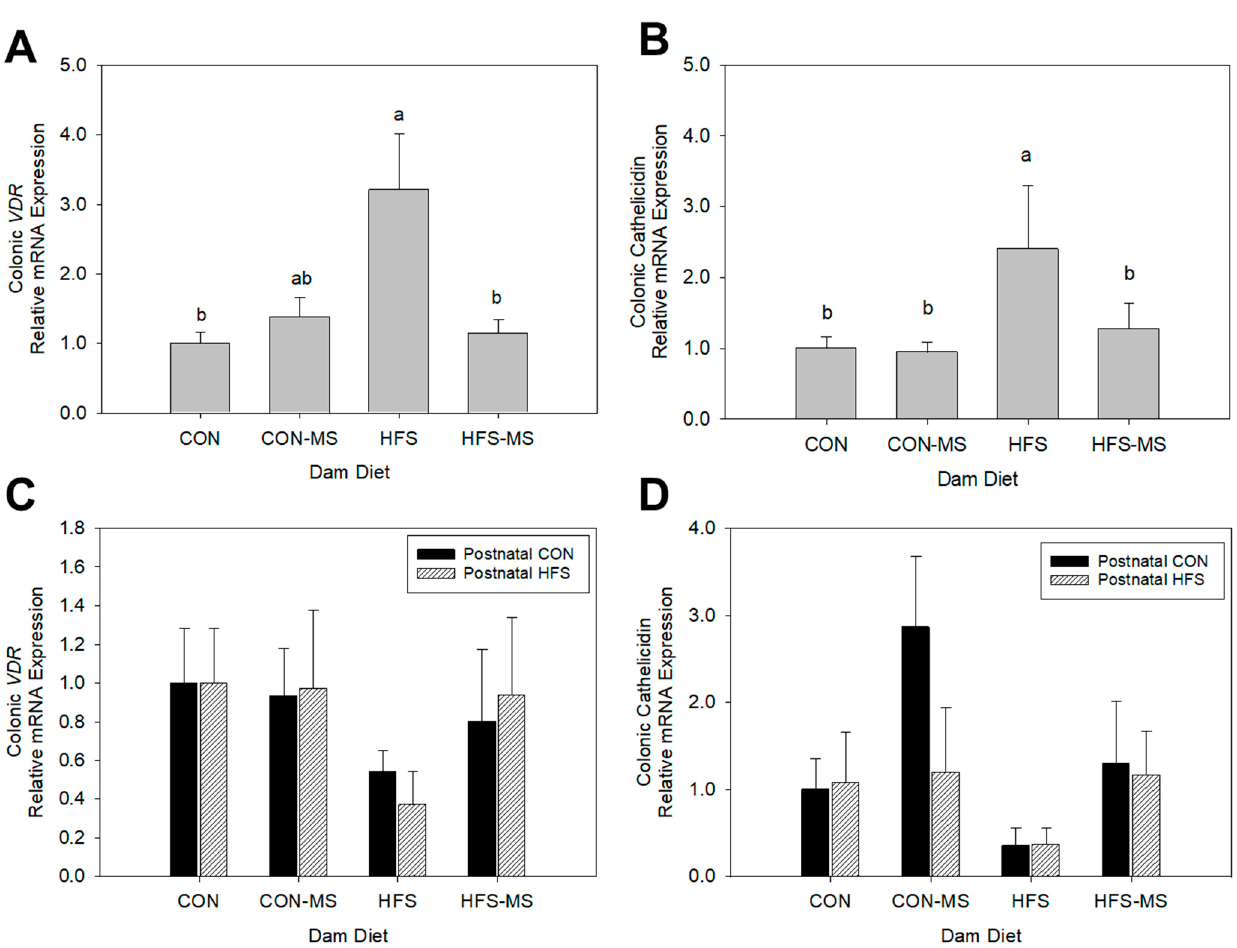
Figure 3. Relative mRNA expression of colonic VDR ( A , C ) and cathelicidin ( B , D ) in weanling ( A , B ) and adult ( C , D ) offspring born to dams fed control (CON) or high-fat, high-sucrose (HFS) diets with or without methyl-donor nutrient supplementation (MS). Data are normalized to GAPDH and expressed in relative to pups of CON dam (weanling) or pups of CON dams fed a p-CON diet (adult). All data are pooled from both sexes. Different letters indicate significant differences between maternal diets at p < 0.05. Data are expressed as mean ± SEM ( n = 6–10/group). Postnatal CON, control postnatal diet; postnatal HFS, high-fat, high-sucrose postnatal diet.